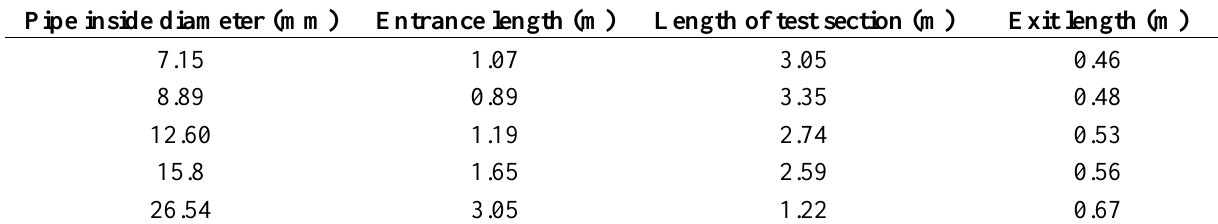
Table 1. Various dimensions of the pipeline flow test sections.